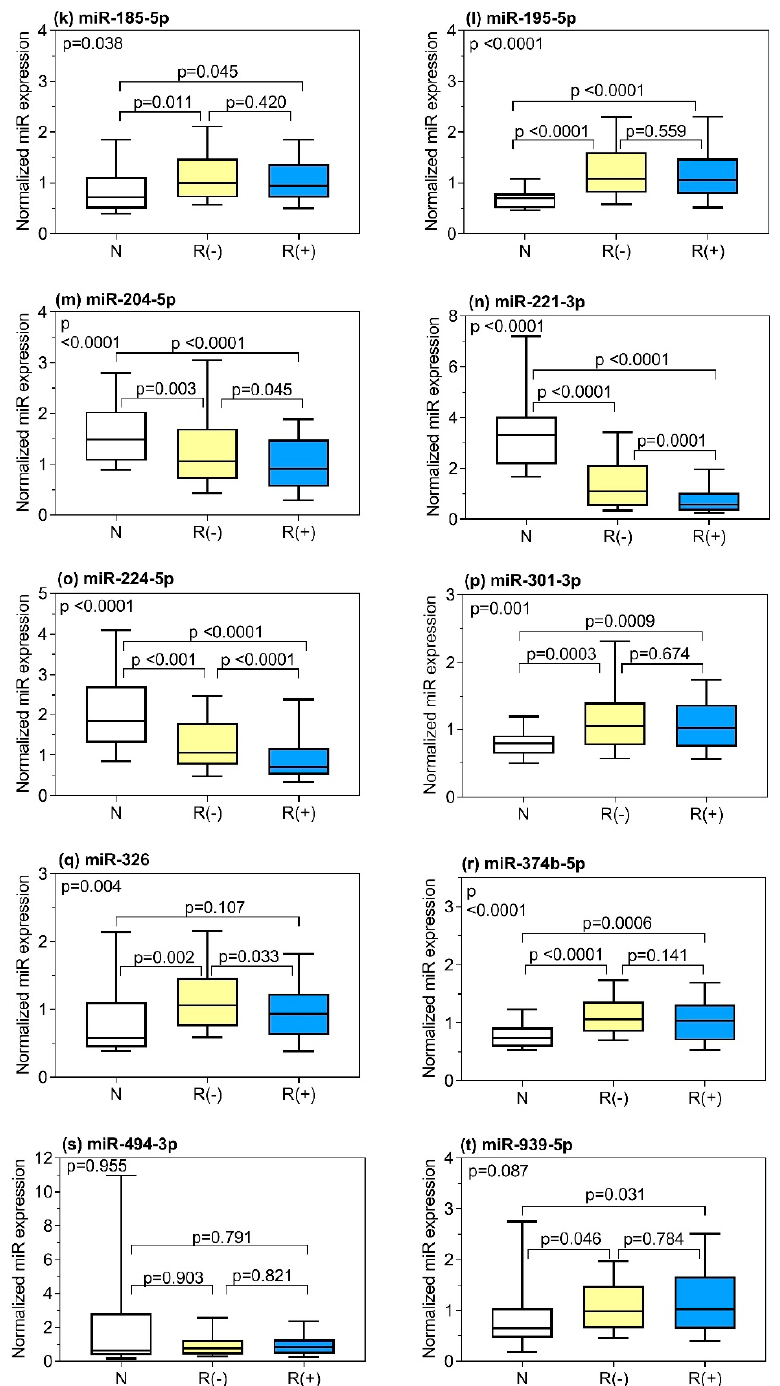
Figure 2. Expression of 20 microRNAs examined in adjacent normal tissue samples and prostate cancer (PCa) tissue samples from patients with and without biochemical recurrence (BCR) are presented in subfigures ( a – t ). Normalized miRNA expression data are given as box- and whisker plots. Boxes represent the lower and upper quartiles with medians; whiskers illustrate the 10 and 90 percentiles of the cohorts. Kruskal–Wallis test with Dunn’s post-hoc was performed. The p -value of the total Kruskal–Wallis test is indicated in the upper left-hand corner of the figure. Abbreviations: N, adjacent normal tissue ( n = 29) as explained in legend of Figure 1; R ( − ), PCa tissue samples from patients without BCR ( n = 108); R ( + ), PCa tissue samples from patients with BCR ( n = 98).